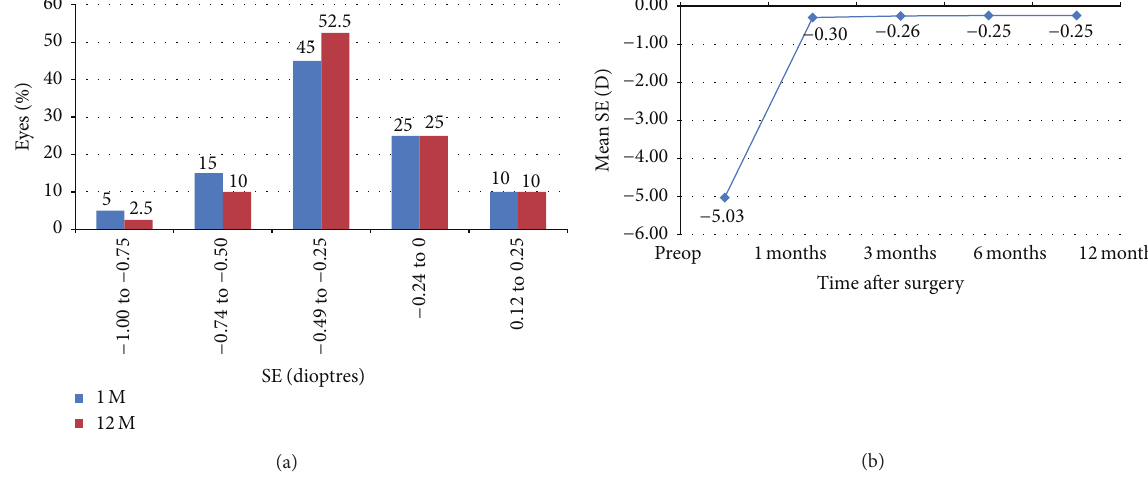
Figure 2: Change/stability of refraction in SE during the follow-up over time ( 𝑛 = 40 eyes) and distribution of postoperative SE (predictability). SE: spherical